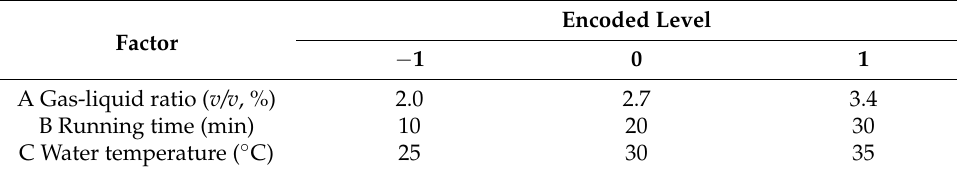
Table 3. Chart of factors and levels used in the Box–Behnken design.